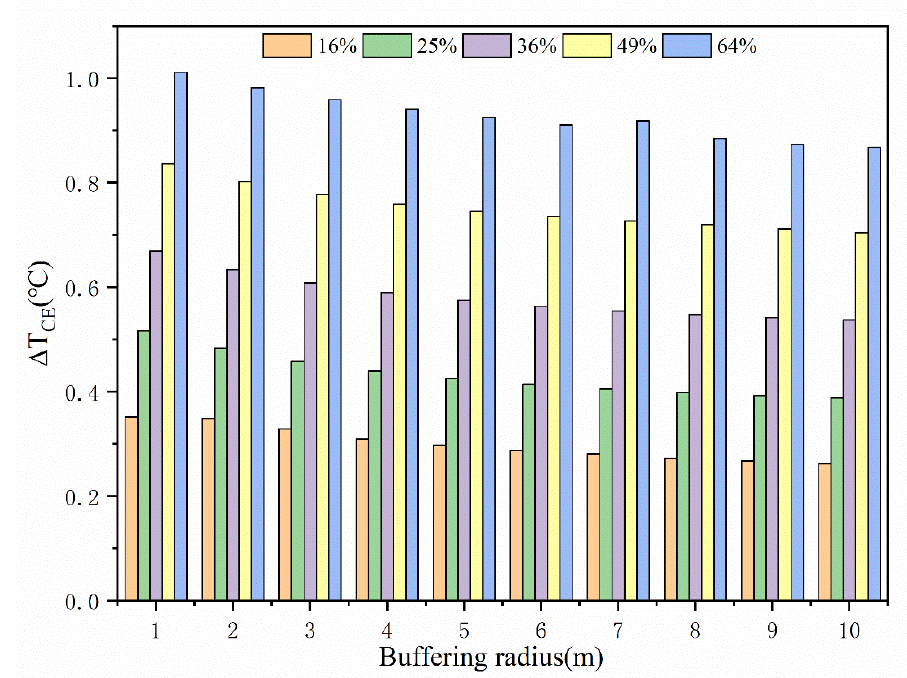
Figure 5. Cooling effect of different water body area proportions in different buffer radii.